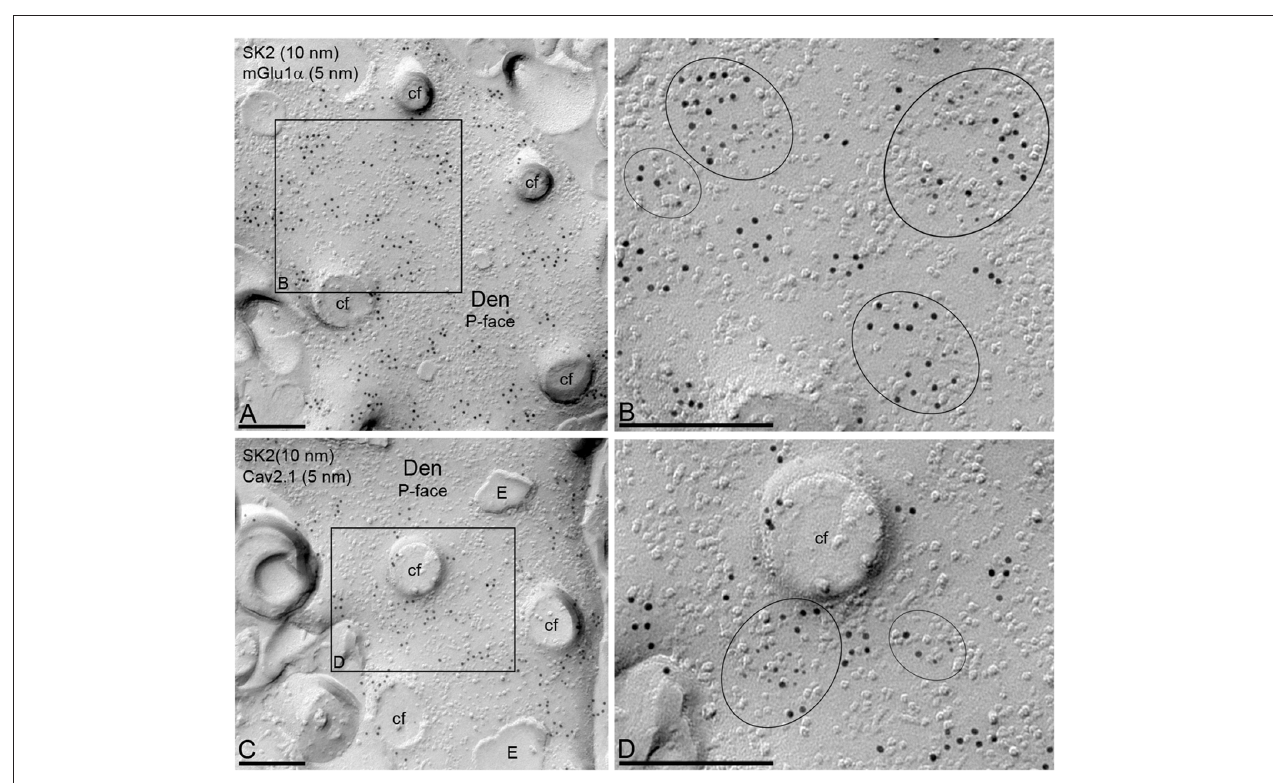
FIGURE 6 | Co-localization of SK2 channels with Ca V 2.1 channels and mGlu 1 α receptor in PC dendritic shafts. Electron micrographs obtained in the molecular layer of the cerebellar cortex showing immunoparticles for SK2, as detected using the SDS-FRL technique. (A,B) Double labeling for SK2 (10 nm) and mGlu 1 α (5 nm) showing their co-clustering in the P-face of PC dendritic shafts (Den). The black box in panel (A) demarcates the dendritic area shown at higher magnification in panel (B) . Clusters of immunoparticles for the two proteins are delineated by black ellipses. (C,D) Double labeling for SK2 (10 nm) and Ca V 2.1 (5 nm) showing their co-clustering in dendritic spines of PCs. The black box in panel (C) demarcates the dendritic area shown at higher magnification in panel (D) . Clusters of immunoparticles for the two proteins are delineated by black ellipses. cf, cross-fracture of dendritic spines; E, E-face. Scale bars: (A–D) 0.2 µ